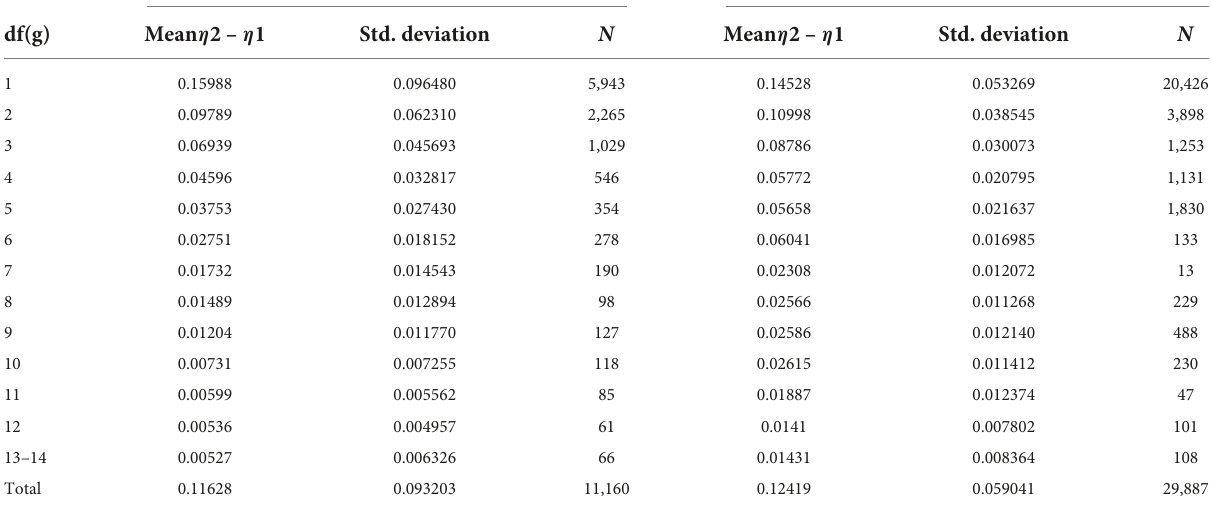
TABLE 3 Difference between eta1 and eta2 by